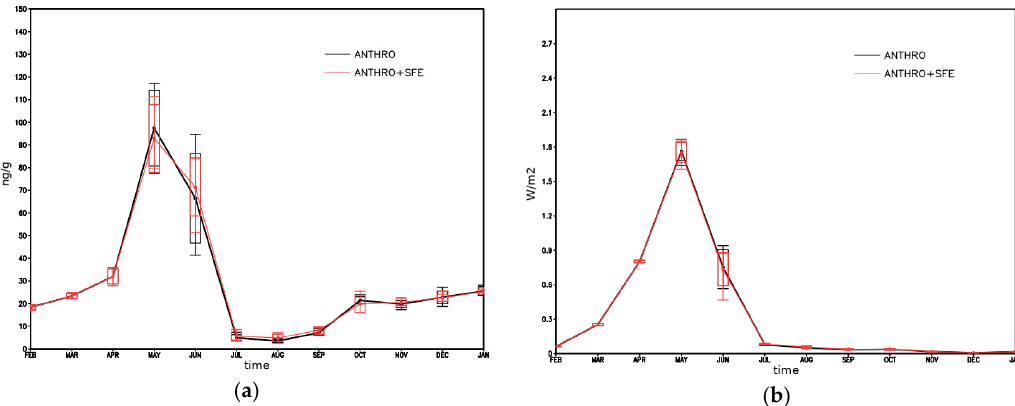
Figure 16. Annual variation of BC concentration in snow, ng/g ( a ), radiation forcing from BC in snow, W/m 2 ( b ) in the Arctic for experiments with ANTHRO and ANTHRO + SFE.